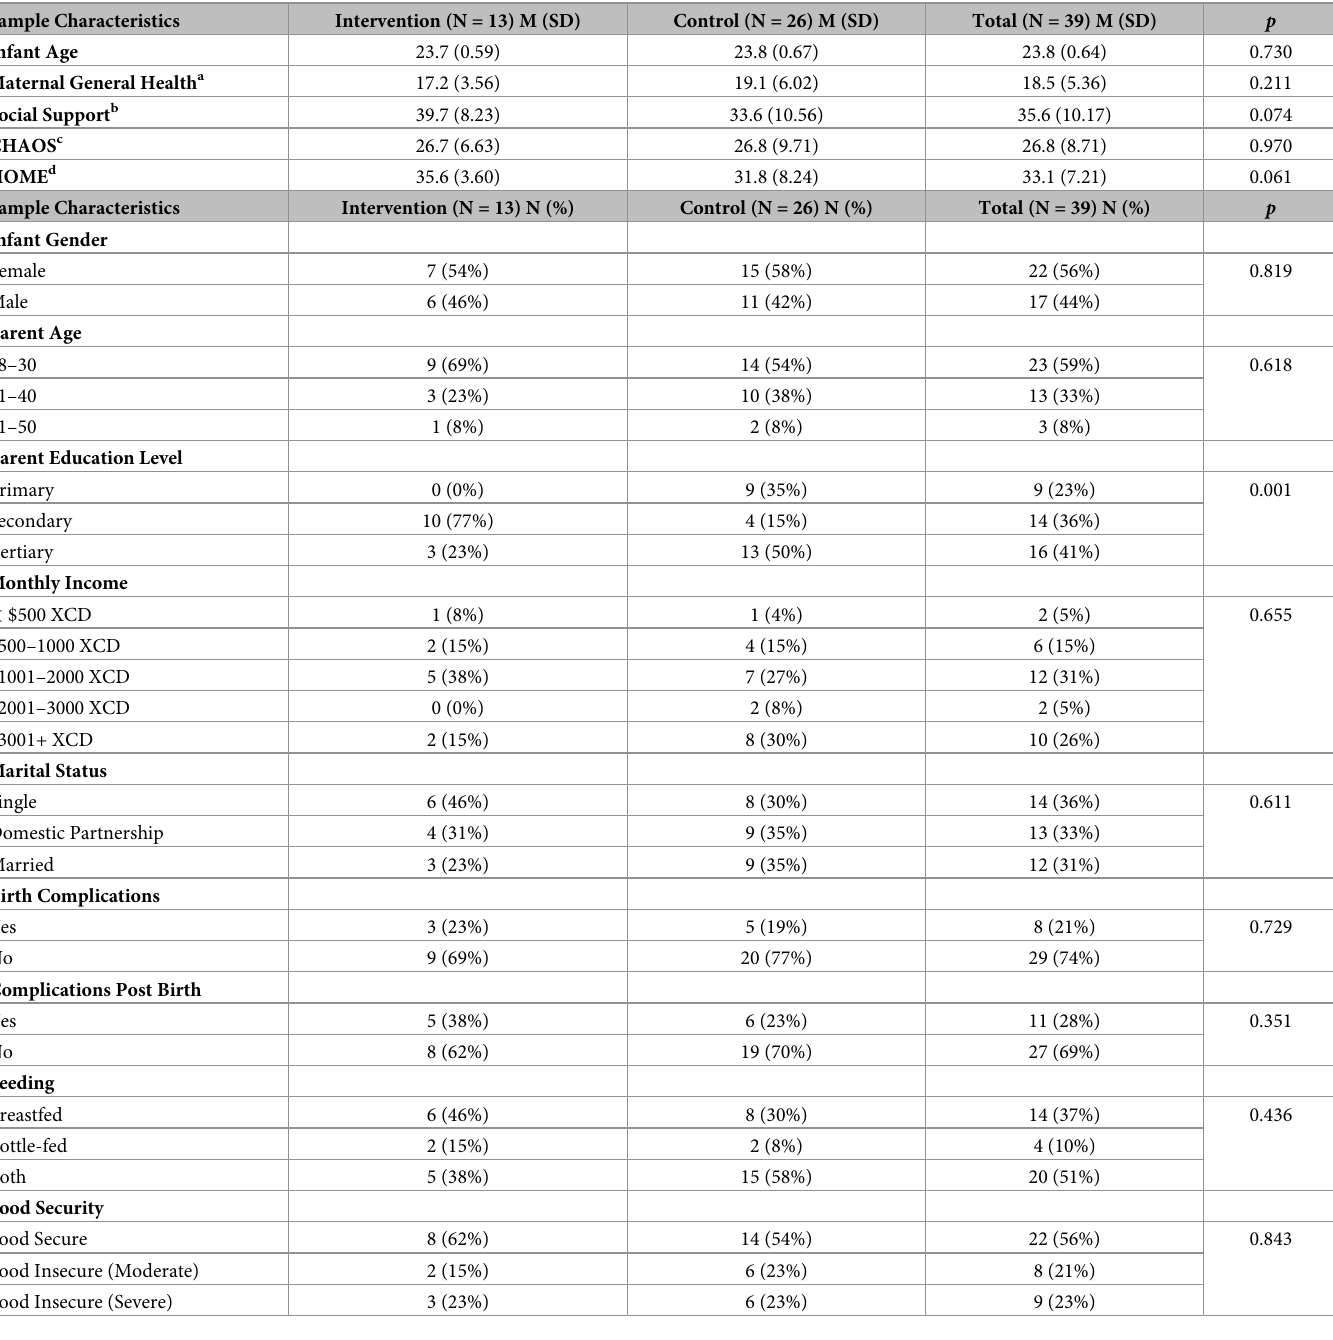
Table 1. Baseline Characteristics of the